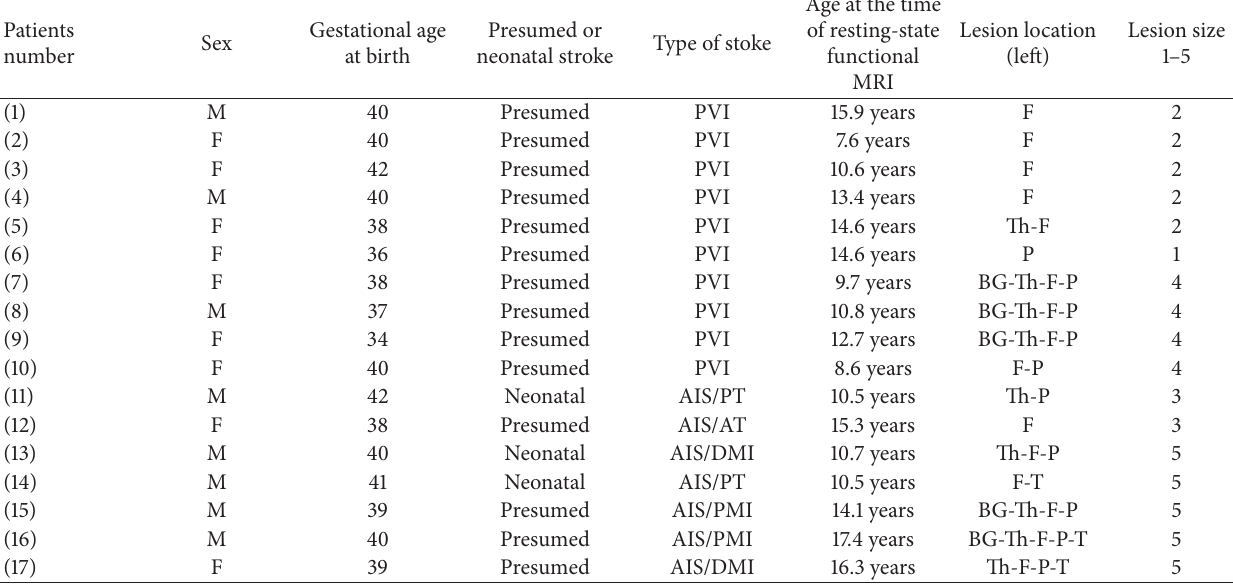
Table 1: Demographic and neuroimaging data for the children with periventricular venous infarction and arterial ischemic stroke.